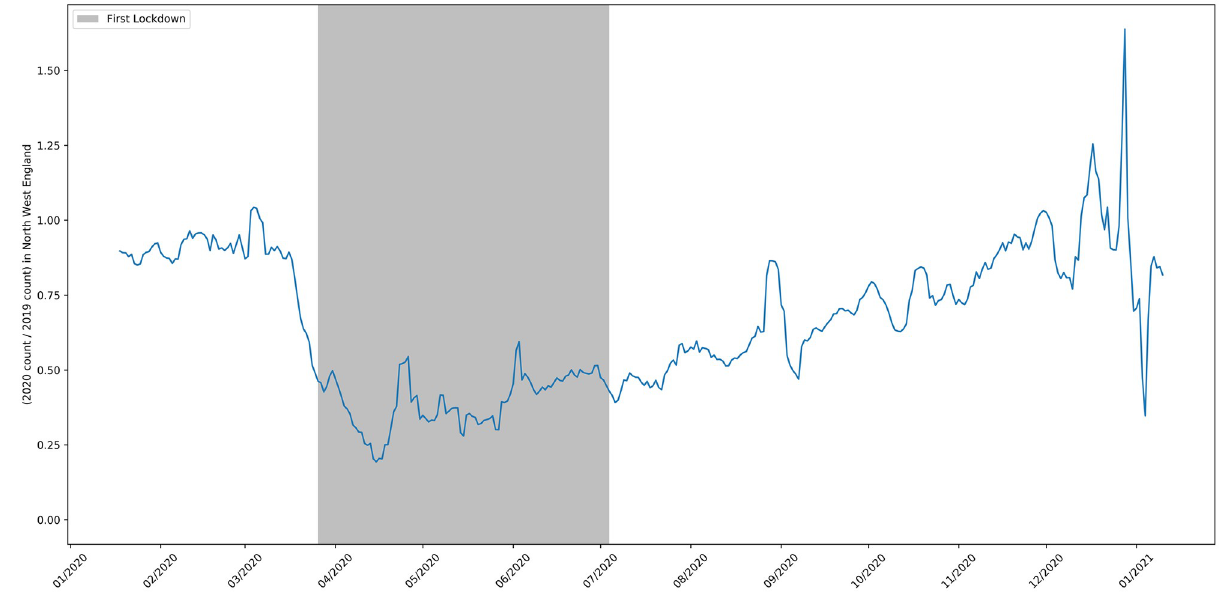
Fig 13. The 2020 to 2019 ratio of job adverts in the South West.